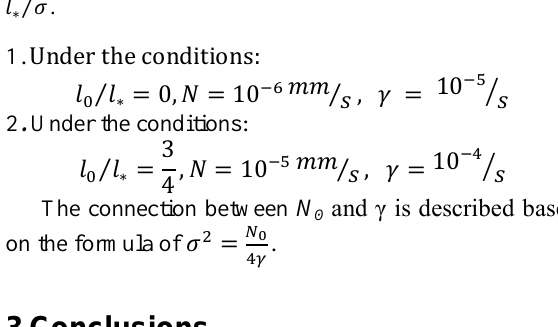
Fig. 3. Curves for estimating an error (dispersion)